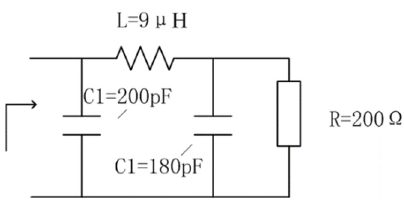
Figure 2. The longest dipole of the miniaturized LPDA. Table 2. Coefficients of the designed LPDA.